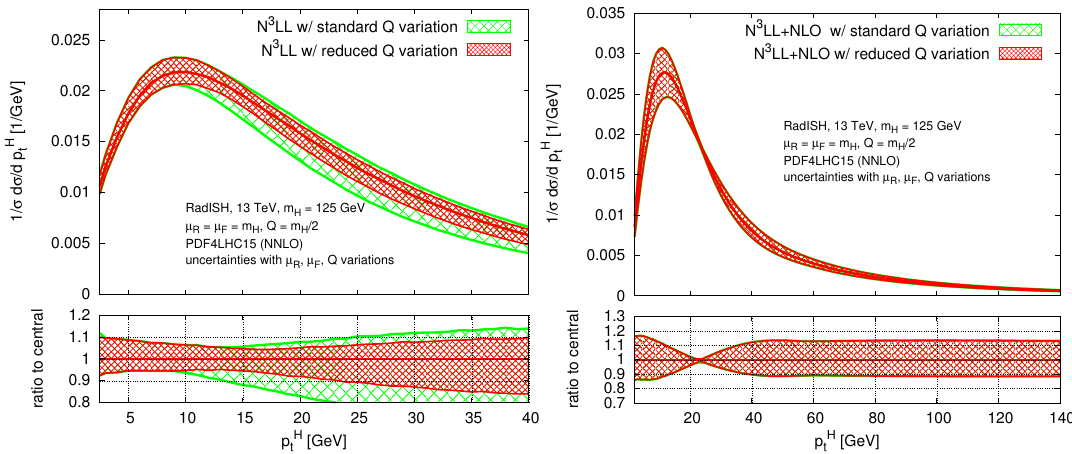
Figure 2 . Comparison between two di(cid:11)erent prescriptions for the resummation-scale-variation range, as described in the text. The comparison is shown both at the resummation level (left) and with a matching to NLO